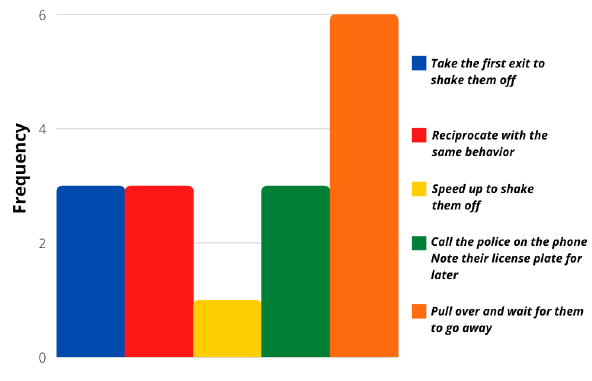
Figure 6. Question 50 results.